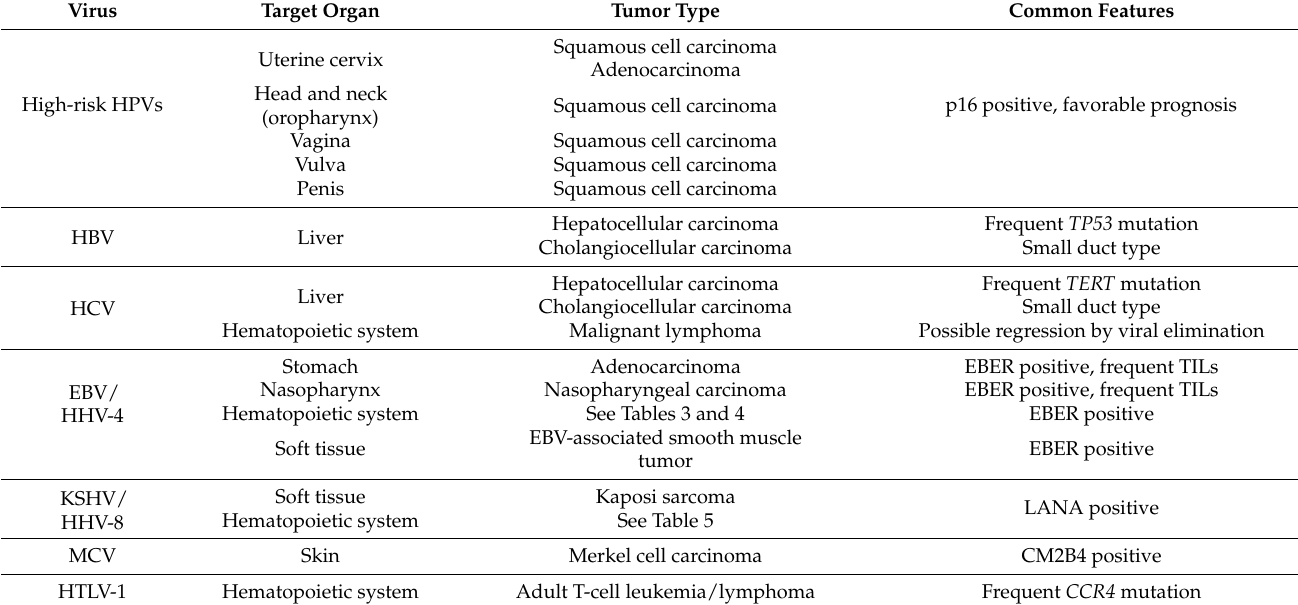
Table 2. Summary of virus-driven